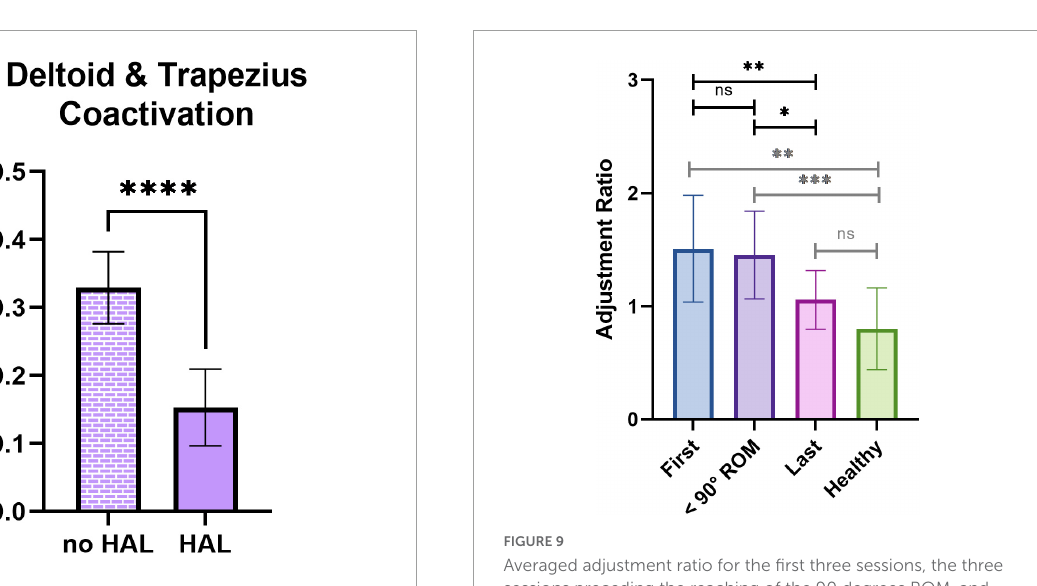
FIGURE7 Coactivation index (CAI) of deltoid and trapezius without and with HAL.